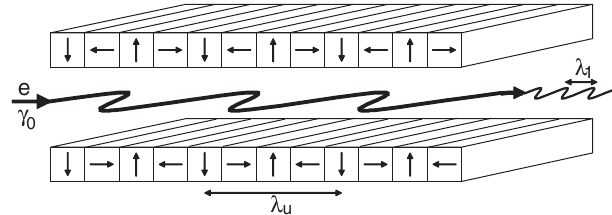
FIG. 1. A wiggling electron in a planar undulator emits undu- lator